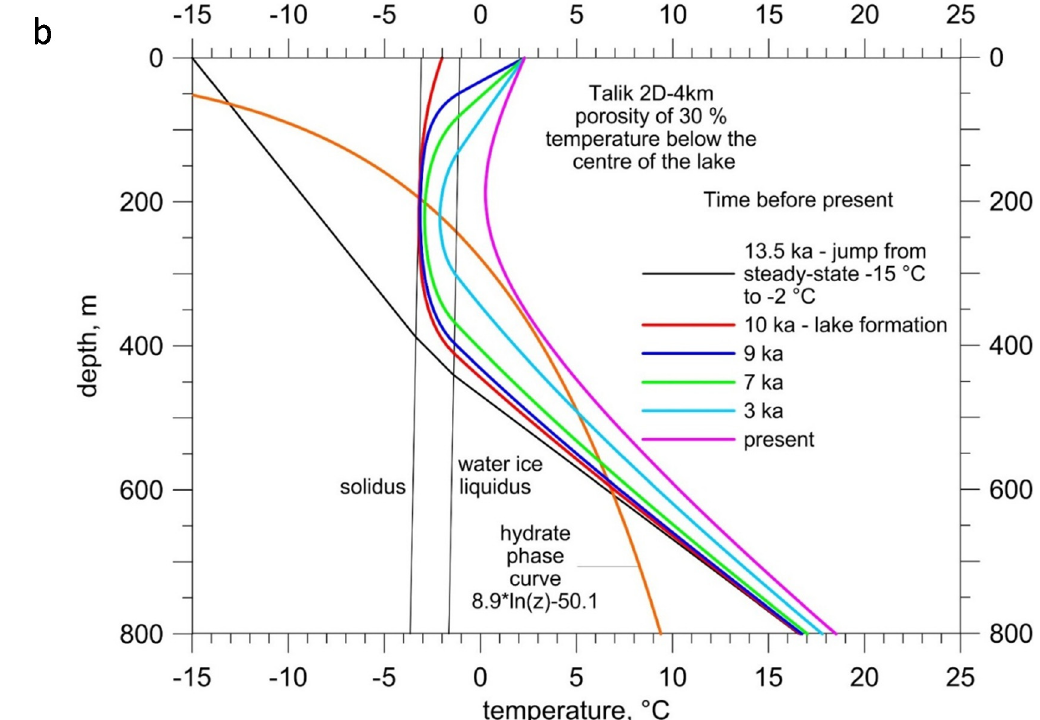
Figure 7. Temperature–depth modeled profiles for 13.5 ka ago, 10 ka ago, 9 ka ago, 7 ka ago, 3 ka ago and Present vs. stability phase boundaries for permafrost and methane GH, ( a ) Sands (30% porosity); ( b ) clayey silt (30%